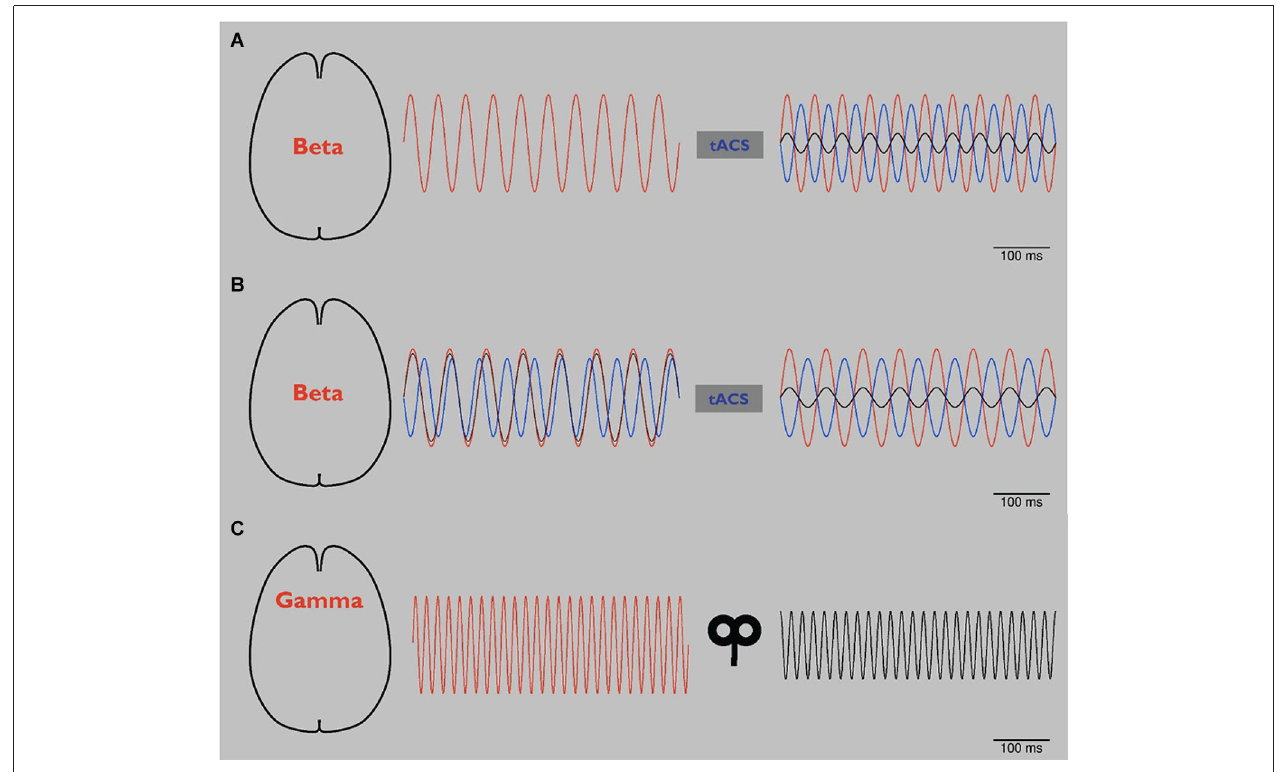
during tACS application tremor frequency changed in patients with PD, more online readout techniques should be developed to adjust NIBS applications. After application of 20 Hz tACS (see panel A ), pathological beta rhythm changes its frequency to 15 Hz (red line, left). tACS of 20 Hz with 180 ◦ phase lag (blue line, left) looses its effect (black line, left). After online adjustment, tACS shifts to 15 Hz (blue line, right). Pathological beta (red line, right) is again reduced (black line, right). (C) Schematic: rTMS in schizophrenia (SCZ). By modulating oscillators of abnormal gamma-band activity (red line, left), amplitude is reduced (black line, right) and related behavioral impairments are